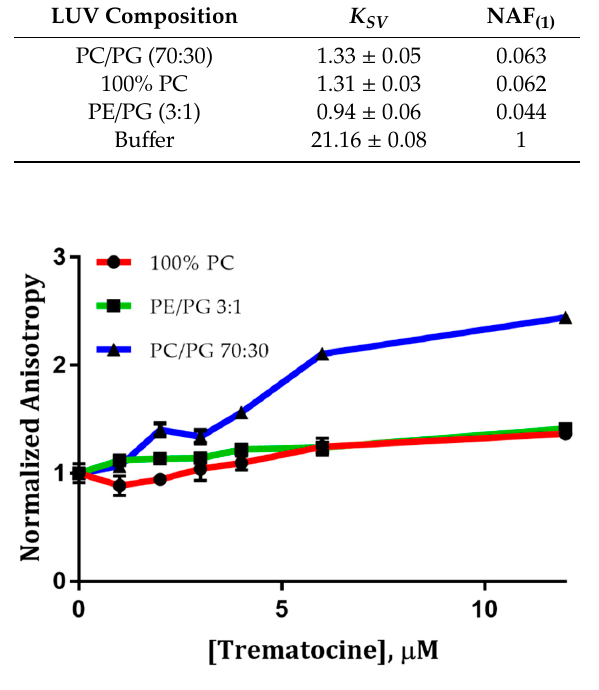
Figure 7. Steady-state fluorescence anisotropy relative to 1,6-Diphenyl-1,3,5-hexatriene (DPH)-containing LUVs, upon interaction with Trematocine. Anisotropy was normalized for each experiment with the r 0 relative to DPH-containing LUVs in the absence of the peptide.